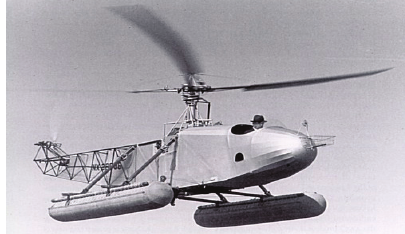
Figure 6 – Igor Sikorsky in the last version of the VS-300, at the end of 1941 Рис . 6 – Окончательная версия VS – 300 Игоря Сикорскго , конец 1941 г . Слика 6 – Игор Сикорски с последњом верзијом VS-300, крајем 1941.